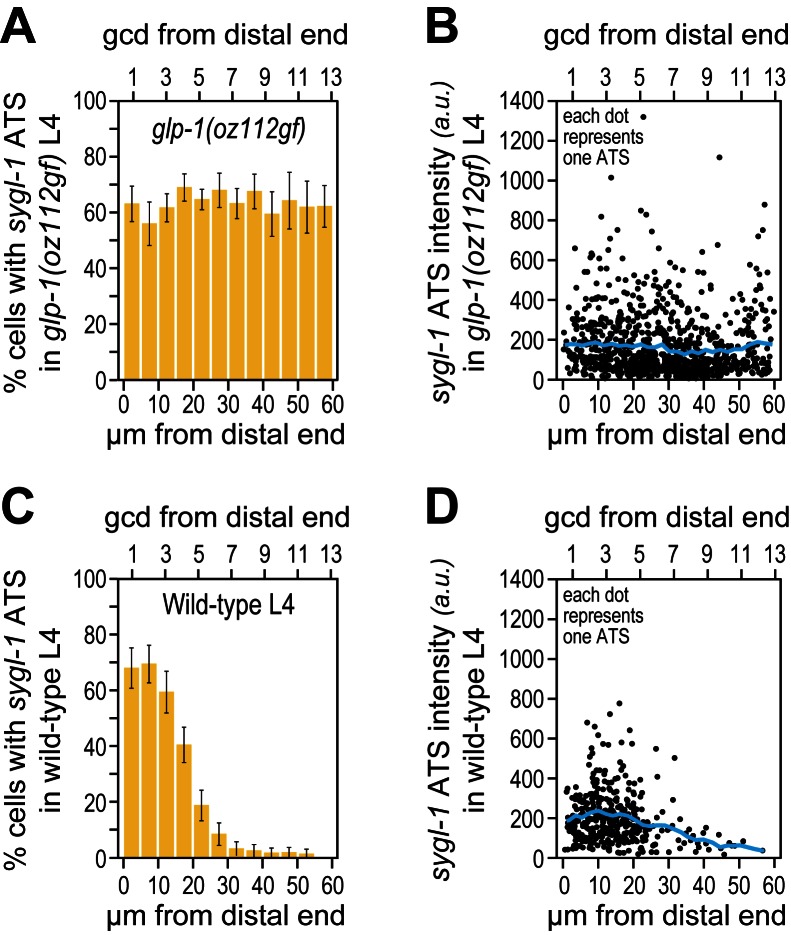
The sygl-1 transcriptional response is not spatially graded in glp-1(oz112gf) mutant germ cells.(A,B) 3528 nuclei from 10 glp-1(oz112 gf) late larval (mid-L4) gonads were used for this analysis. Adult glp-1(GF) were not assayed here, because their distal germlines are mitotically quiescent and therefore not similar to wild type. (C,D) 1902 nuclei from 24 wild-type (mid-L4) gonads were used. (A,C) Percentage of germ cell nuclei with any sygl-1 ATS as a function of distance from distal end in glp-1(oz112 gf) (A) or wild type (C). (B,D) Intensities of individual sygl-1 ATS as a function of position in glp-1(oz112 gf) (B) or wild type (D), as in Figure 3E.